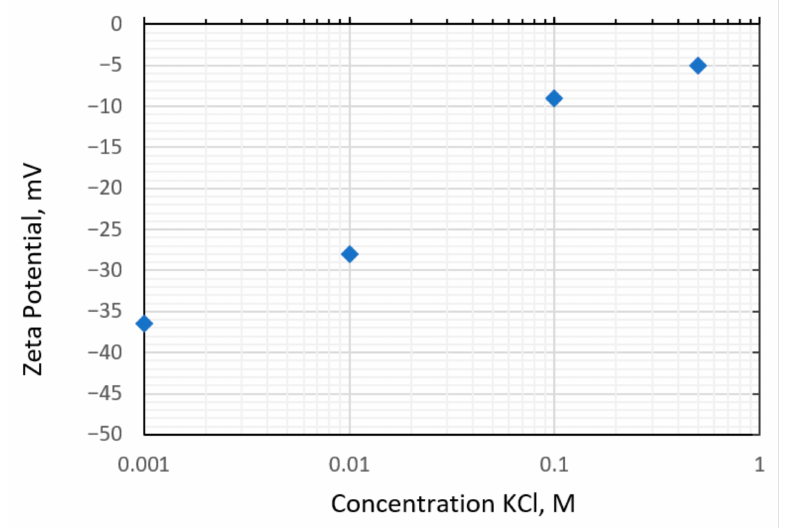
Figure 2. Zeta potential of spodumene tailings with the presence of KCl (salt) in deionized water and without flocculant. Salt concentrations 0.001, 0.01, 0.1 and 0.5